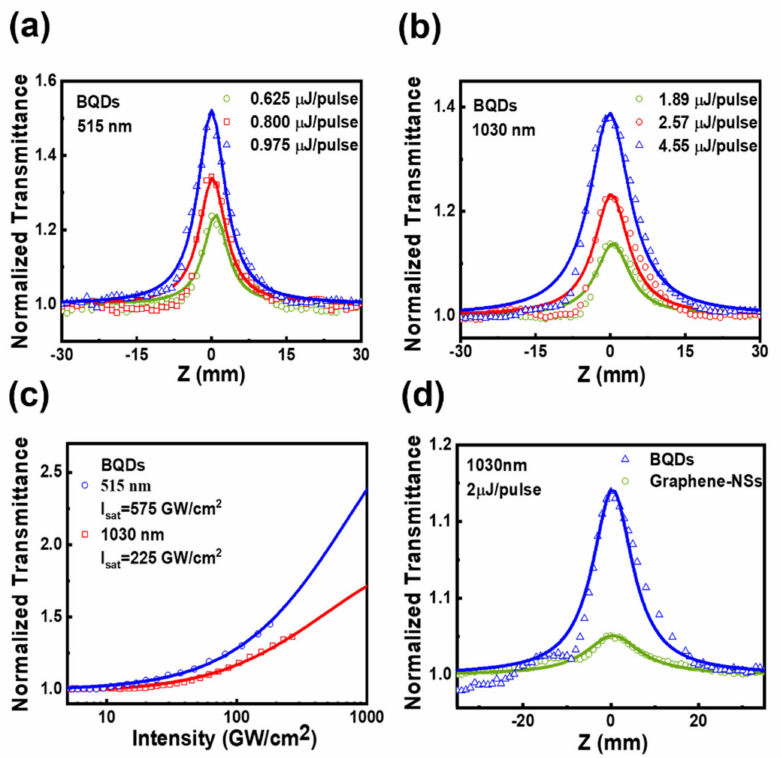
Figure 3. ( a , b ) the open aperture z-scan measurements of BQDs under different intensities at 515 nm and 1030 nm, respectively. ( c ) the normalized transmittance and input intensity of BQDs at 515 nm and 1030 nm. ( d ) the open aperture z-scan measurements of BQDs and graphene nanosheets under the excitation of 2 µ J/pulse at 1030